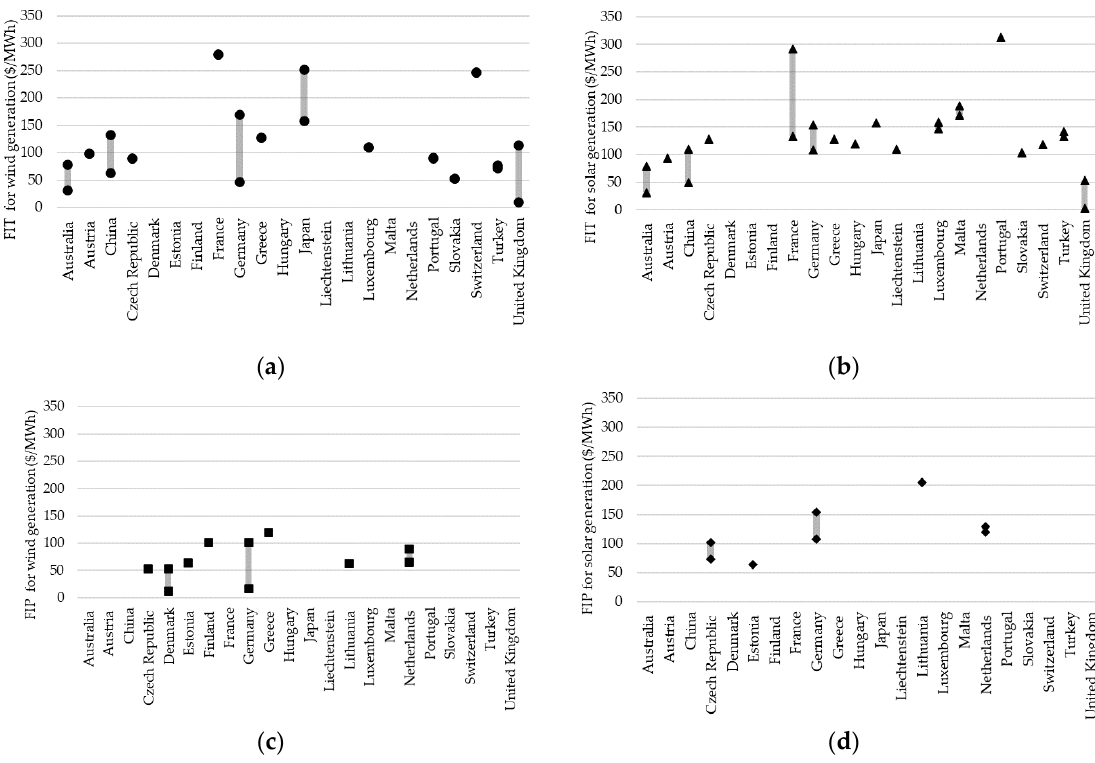
Figure 5. ( a ) FIT for wind generation data. ( b ) FIT for solar generation data. ( c ) FIP for wind generation data. ( d ) FIP for solar generation data [17,44–47].